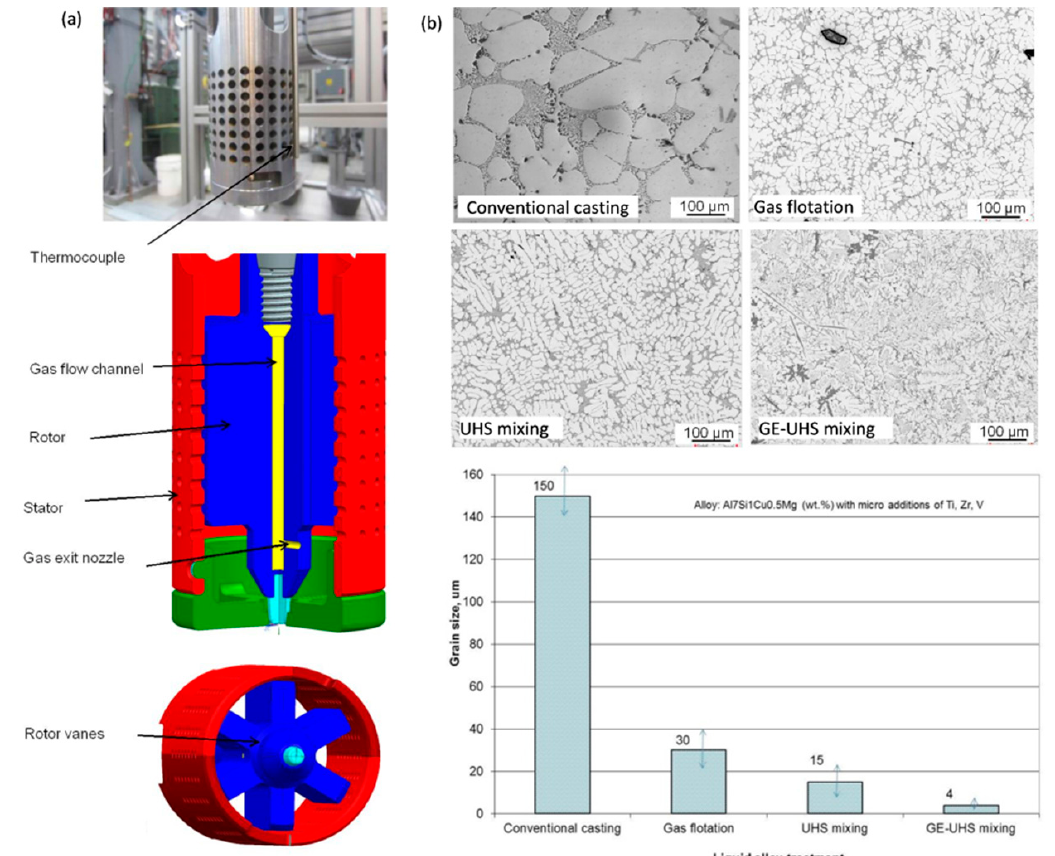
Figure 27. Application of Gas − Enhanced Ultrahigh Shear Mixing for refining microstructure of Al7Si1Cu0.5Mg alloy with 0.47 wt.% Zr, 0.21 wt.% Ti, 0.30 wt.% V: ( a ) mixing device; ( b ) microstructure after different treatments in liquid state with resultant grain size shown on histograms [129].